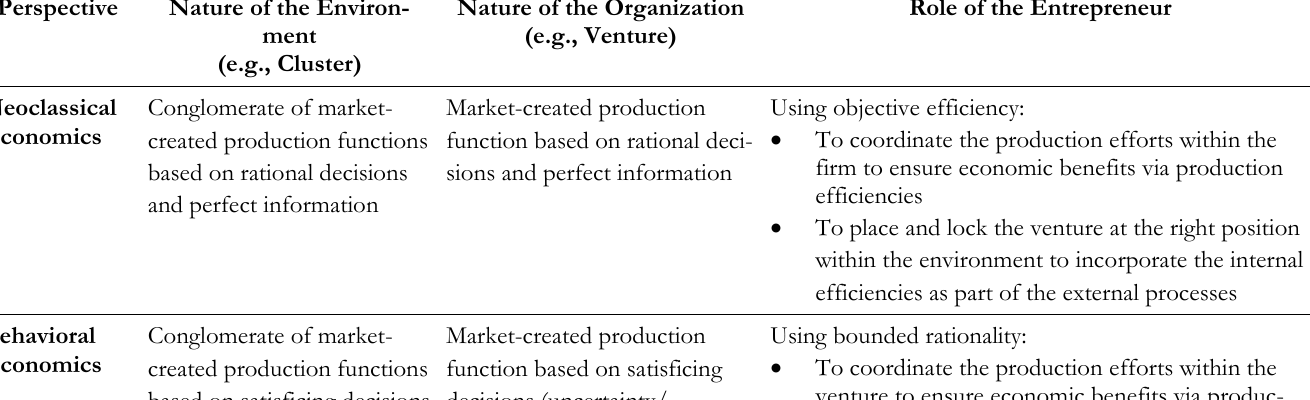
Table 1. Rationalistic/Economic